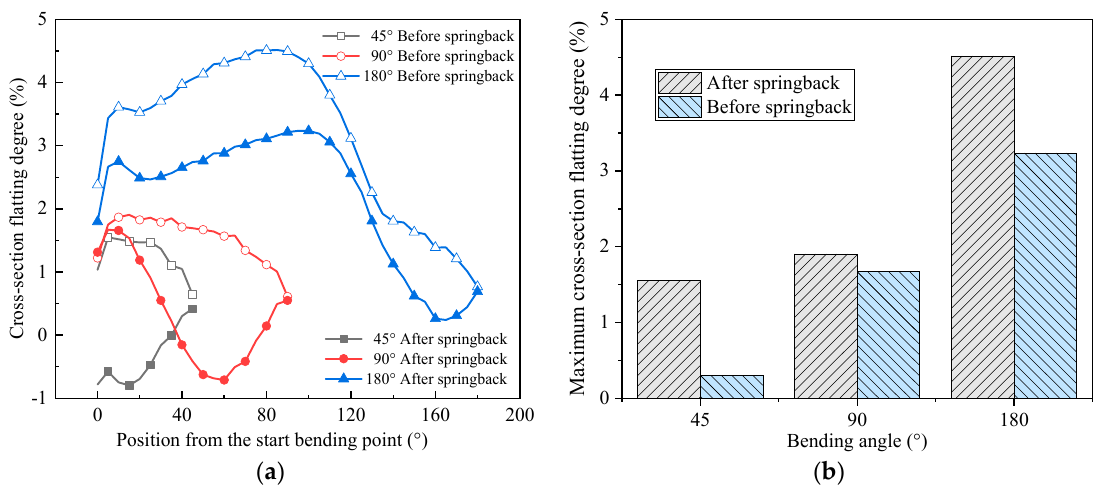
Figure 12. Variation of cross-section flatting under different bending angles at 250 °C: ( a ) distribution along bending angle; ( b ) maximum flattening.